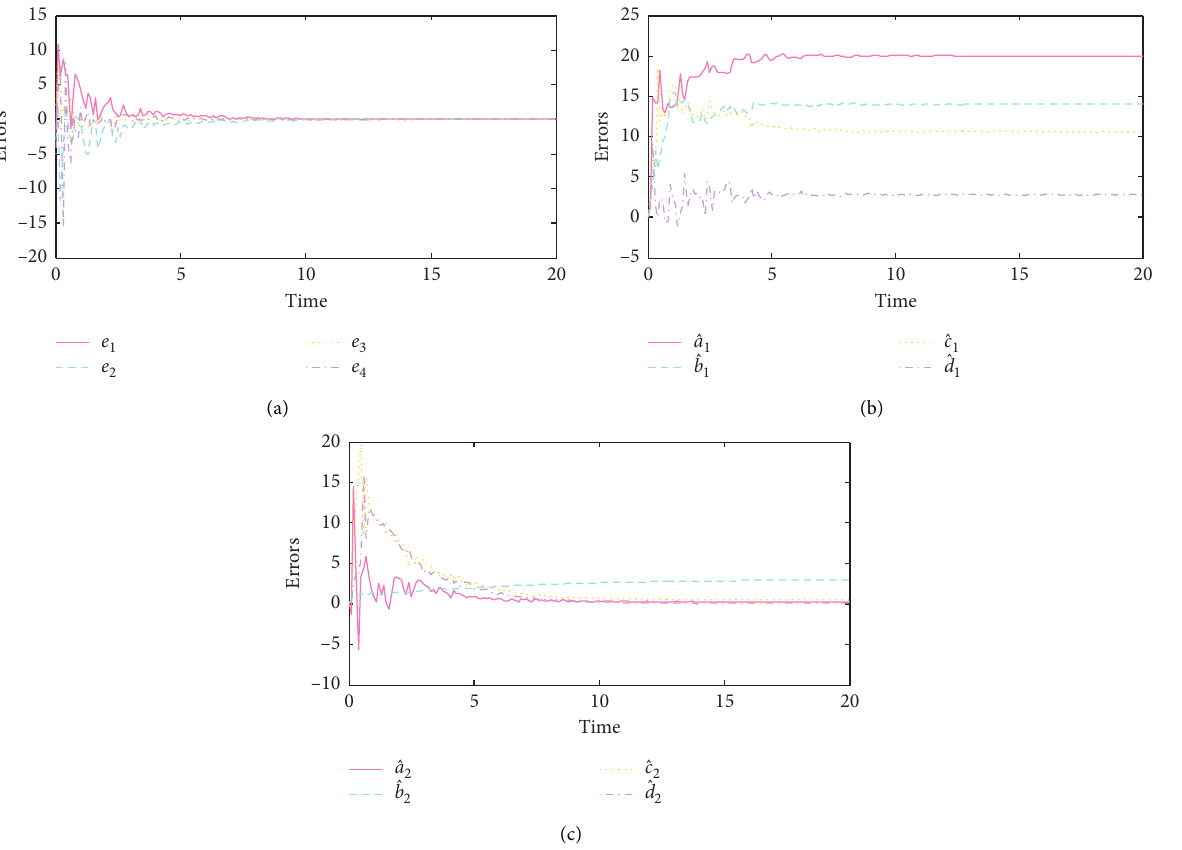
Figure 4: (a) Trajectories of the errors; (b) trajectories of the drive system unknown parameter estimates; (c) trajectories of the response system unknown parameter estimates.